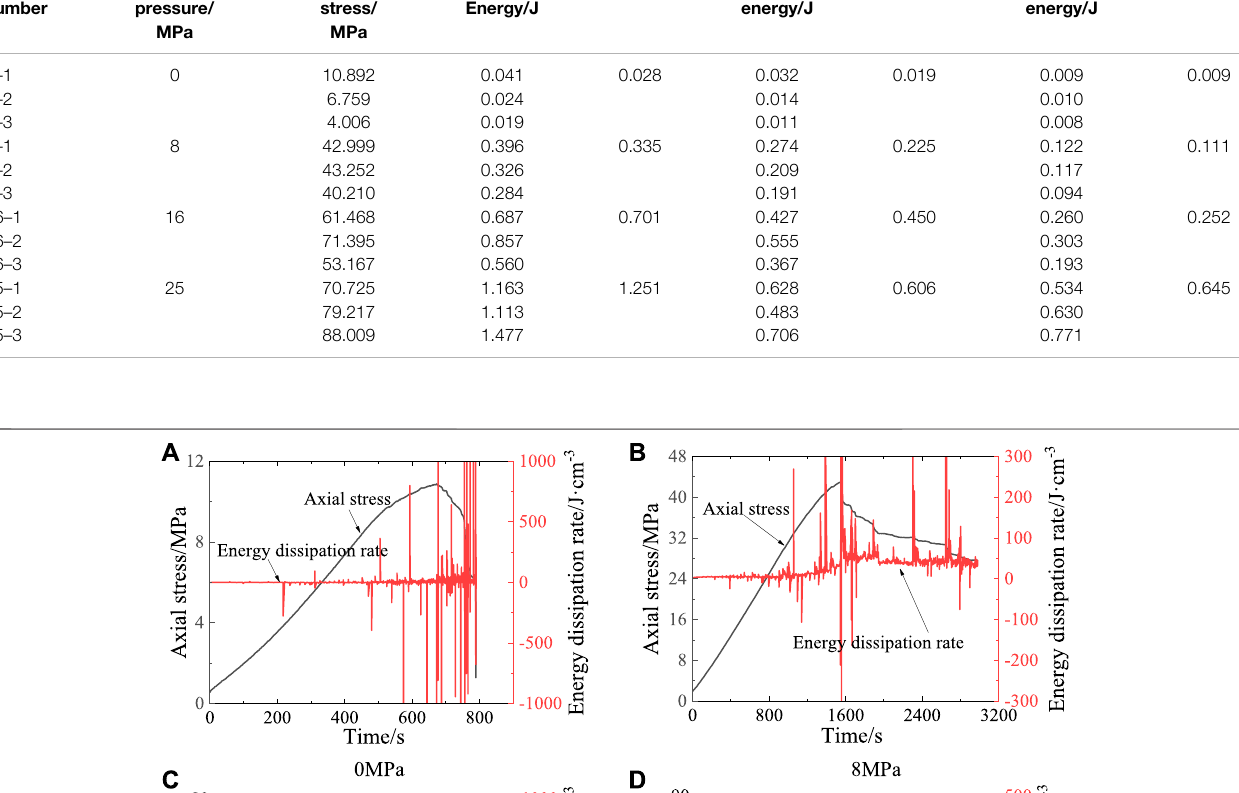
Frontiers in Earth Science |